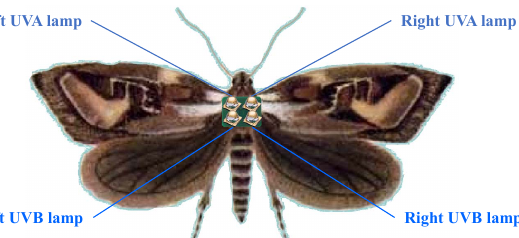
Figure 1. Illustration of a cyborg moth equipped with a backpack chip.